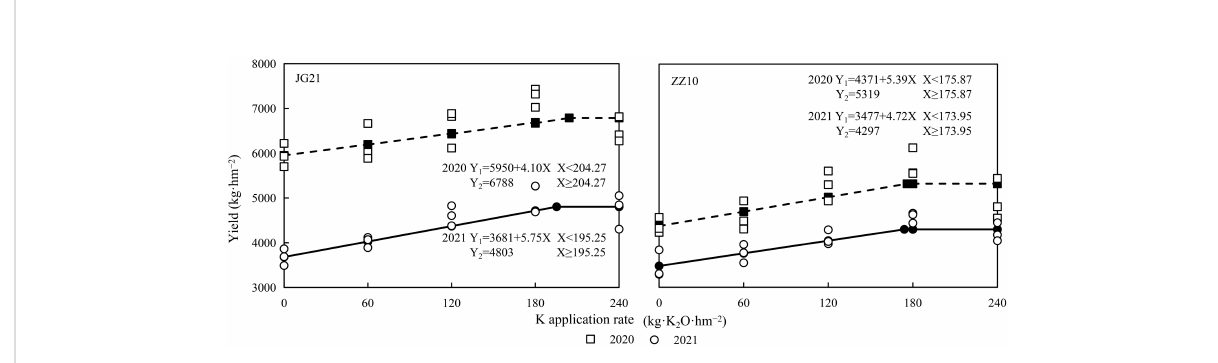
FIGURE 7 Effect of potassium application rate on yield of millet varieties, Jingu 21 (JG21) and Zhangza 10